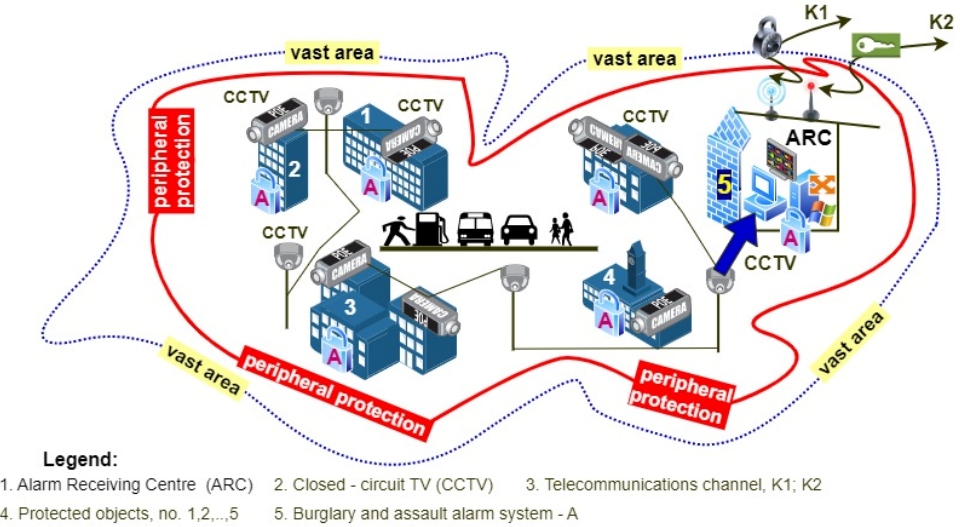
Figure 1. Simplified diagram of ensuring security over vast areas and in buildings using two elec- tronic security systems—CCTV and IDS. Designations used in the figure are explained in the figure key. figure